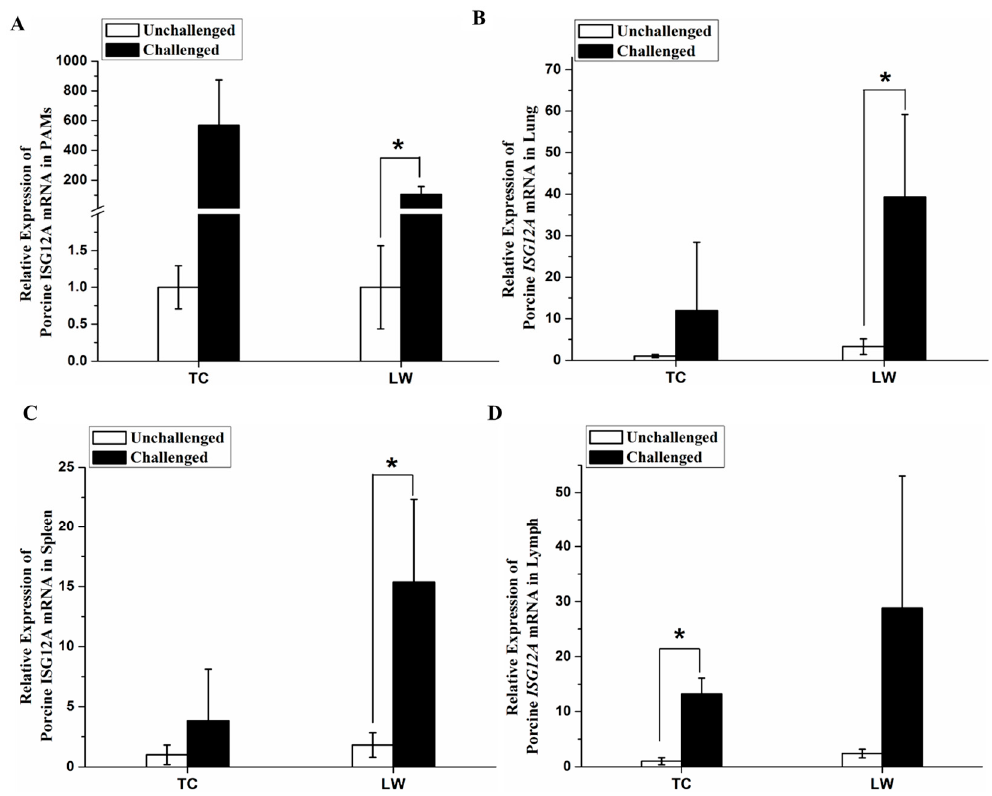
Figure 4. Porcine ISG12A mRNA expression was in different cells/tissues after PRRSV challenge. ( A ) Porcine alveolar macrophages (PAMs); ( B ) Lung; ( C ) Spleen; ( D ) Inguinal lymph nodes. “LW” represents Large White pigs and “TC” represents Tongcheng pigs. Student’s t -test: * p < 0.05.